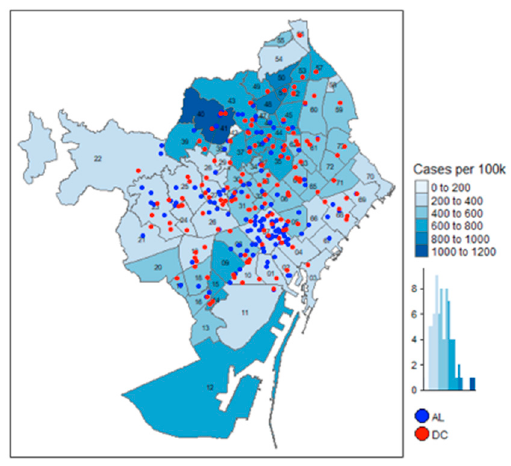
Figure 5. Location of AL/DC and total cases.